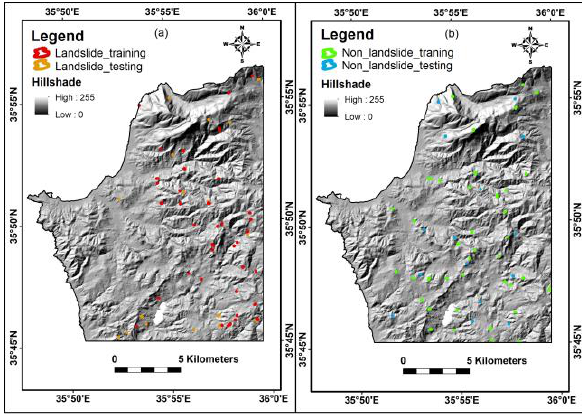
Figure 7. The hillshade map of the study area. a- Landslide dataset and inventory map. b- Non-landslide dataset. Also, slope map (Figure 8-a), aspect map (Figure 8-b), curvature map (Figure 8-c), and distance map from streams (Figure 8-d) were prepared from the DEM extracted from the topographic map which was used also to prepare the distance map from roads (Figure 9).